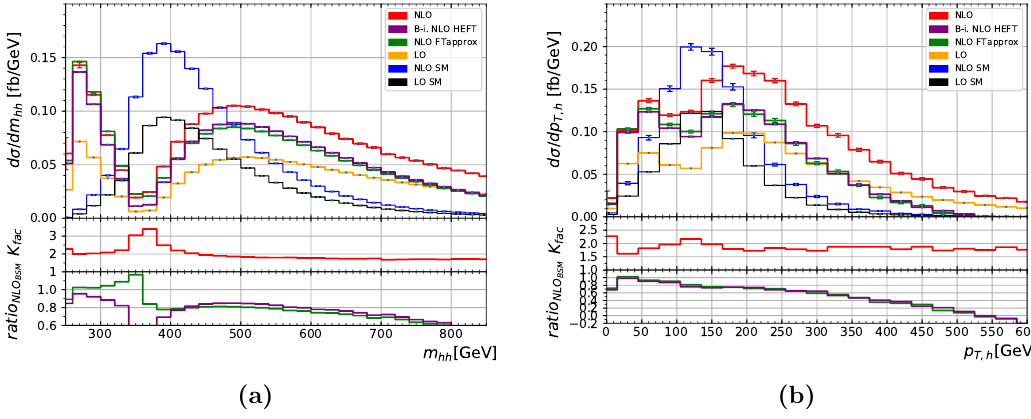
Figure 17. Same as (cid:12)gure 12 but for benchmark point 5, c hhh = 1 ; c t = 1 ; c tt = 0 ; c ggh = 8 = 15 ; c gghh = 1 =